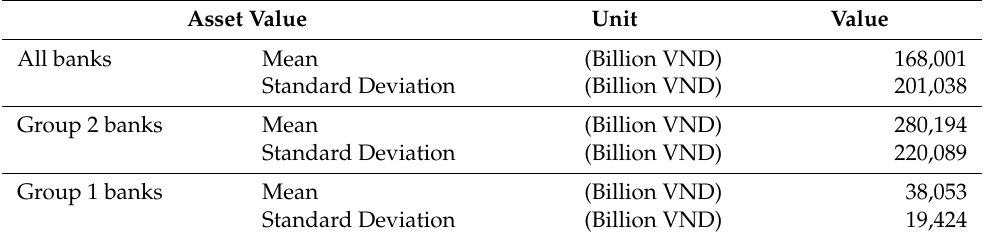
Figure A3. SOM’s dendrograms. Note: these figures are dendrograms (2008–2017). Source: author’s analysis. Table A3. Summary mean asset values for super-class group one and group two banks.